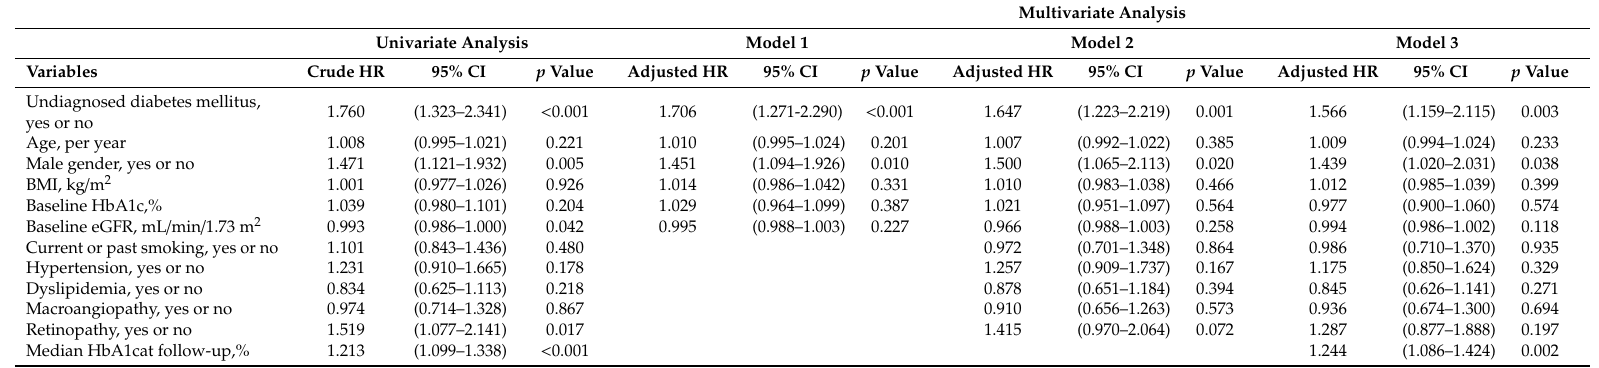
Table 2. Univariate and multivariate hazard ratio for onset of